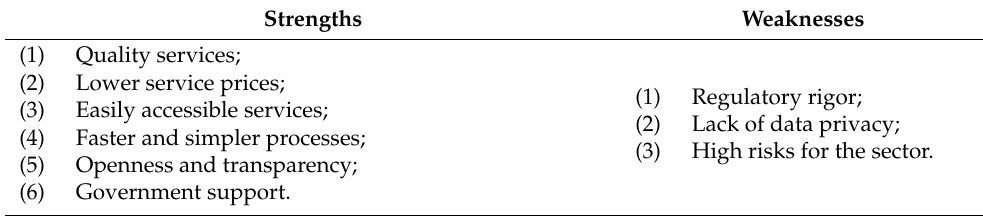
Table 8. FinTech sector strengths, weaknesses, opportunities, and threats SWOT analysis. (Composed by the